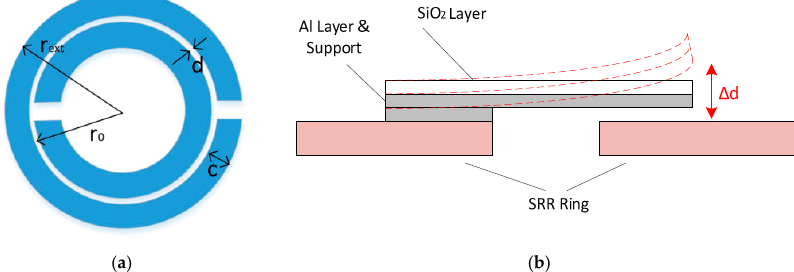
Figure 12. Split Ring Resonator—Adapted from Reference [47] ( a ) and Bi-metallic Strip—Adapted from Reference [183] ( b